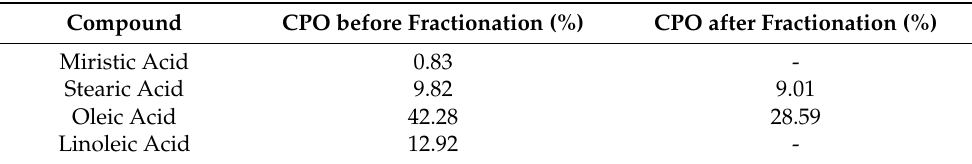
Table 2. Chemical composition of CPO before and after fractionation.